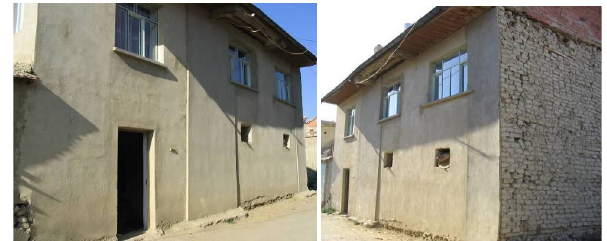
Fig. 19 Welded wire mesh application on adobe structure